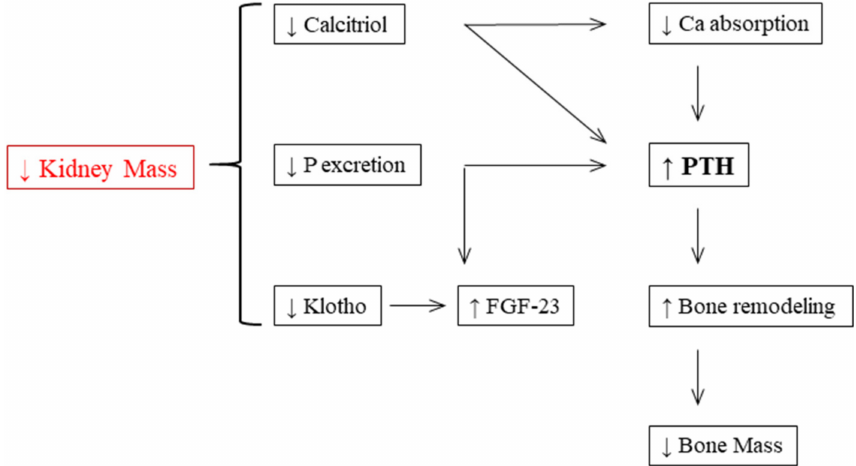
Figure 2. The pathophysiology of CKD-MBD (modified after [11]). P: phosphate; FGF-23: fibroblast growth factor 23; Ca: calcium; PTH: parathyroid